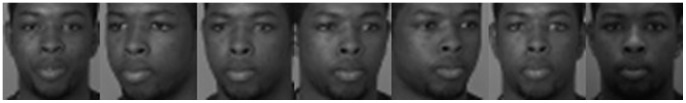
Some face images from the FERET database.